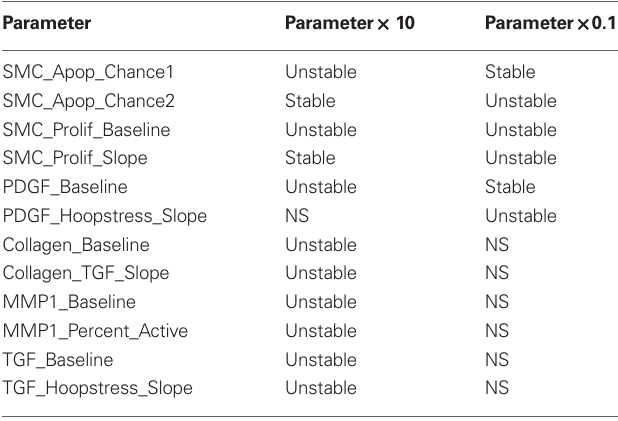
Table 4 | Agent-based model